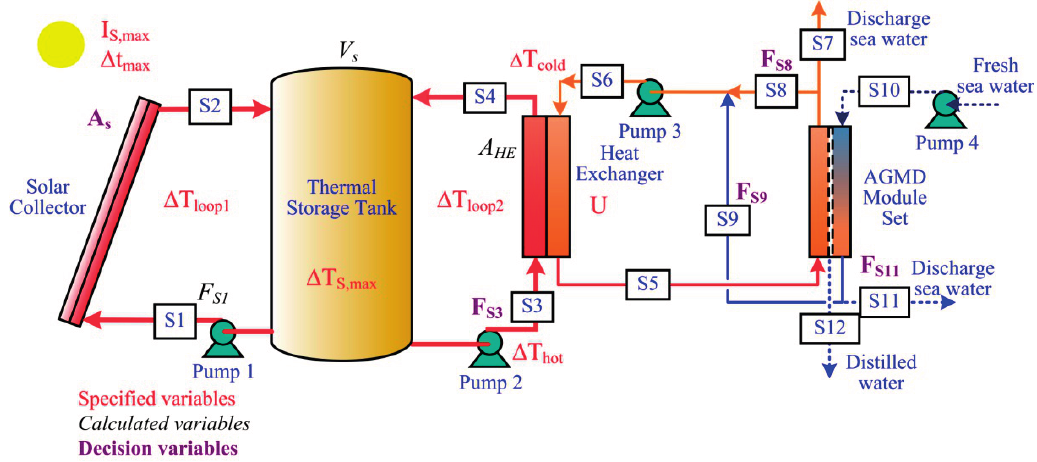
Figure 1. The small-scale solar membrane distillation desalination system (s-SMDDS). AGMD, air gap membrane